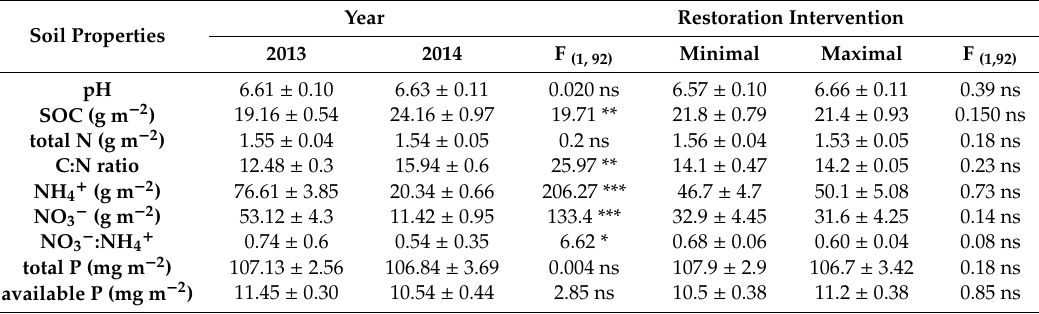
Table 2. Mean and standard error of topsoil (0–10 cm depth) properties in Quilamula, Morelos, Mexico. Soil properties in 2013 and 2014 and under minimal and maximal restoration intervention are shown. F and p values are from ANOVAs between years (2013 and 2014) and intervention (minimal and